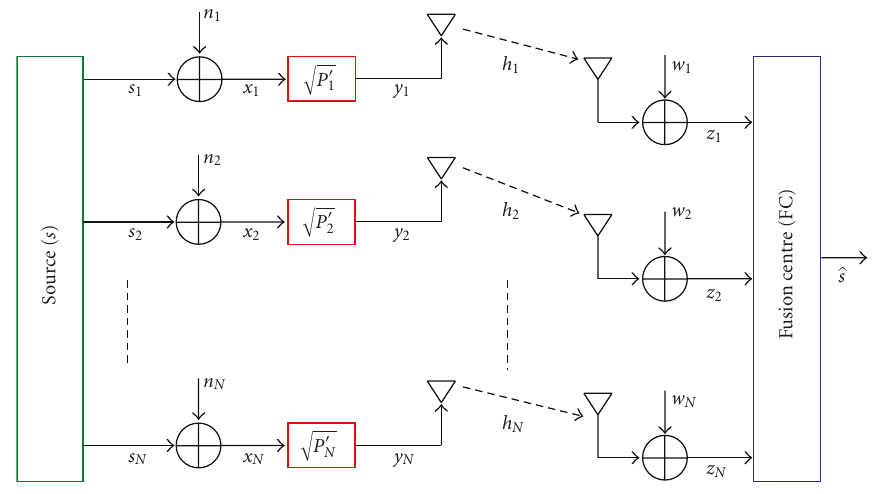
Figure 1: Block diagram of the